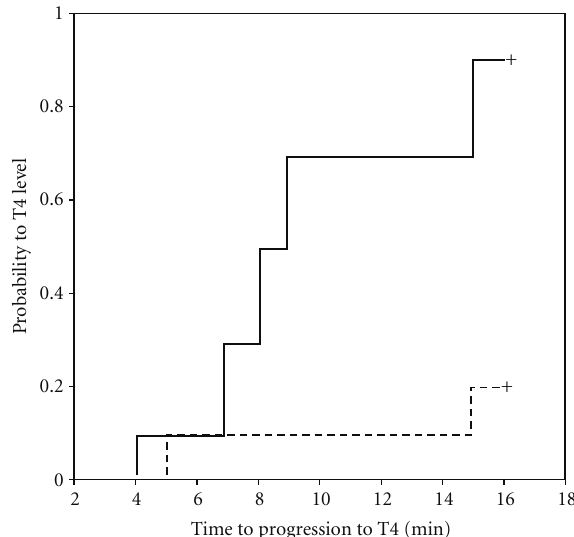
Figure 3: Comparison of time to T4 after isobaric (dotted line) and hyperbaric (dashed line) levobupivacaine ( P = 0 . 002).